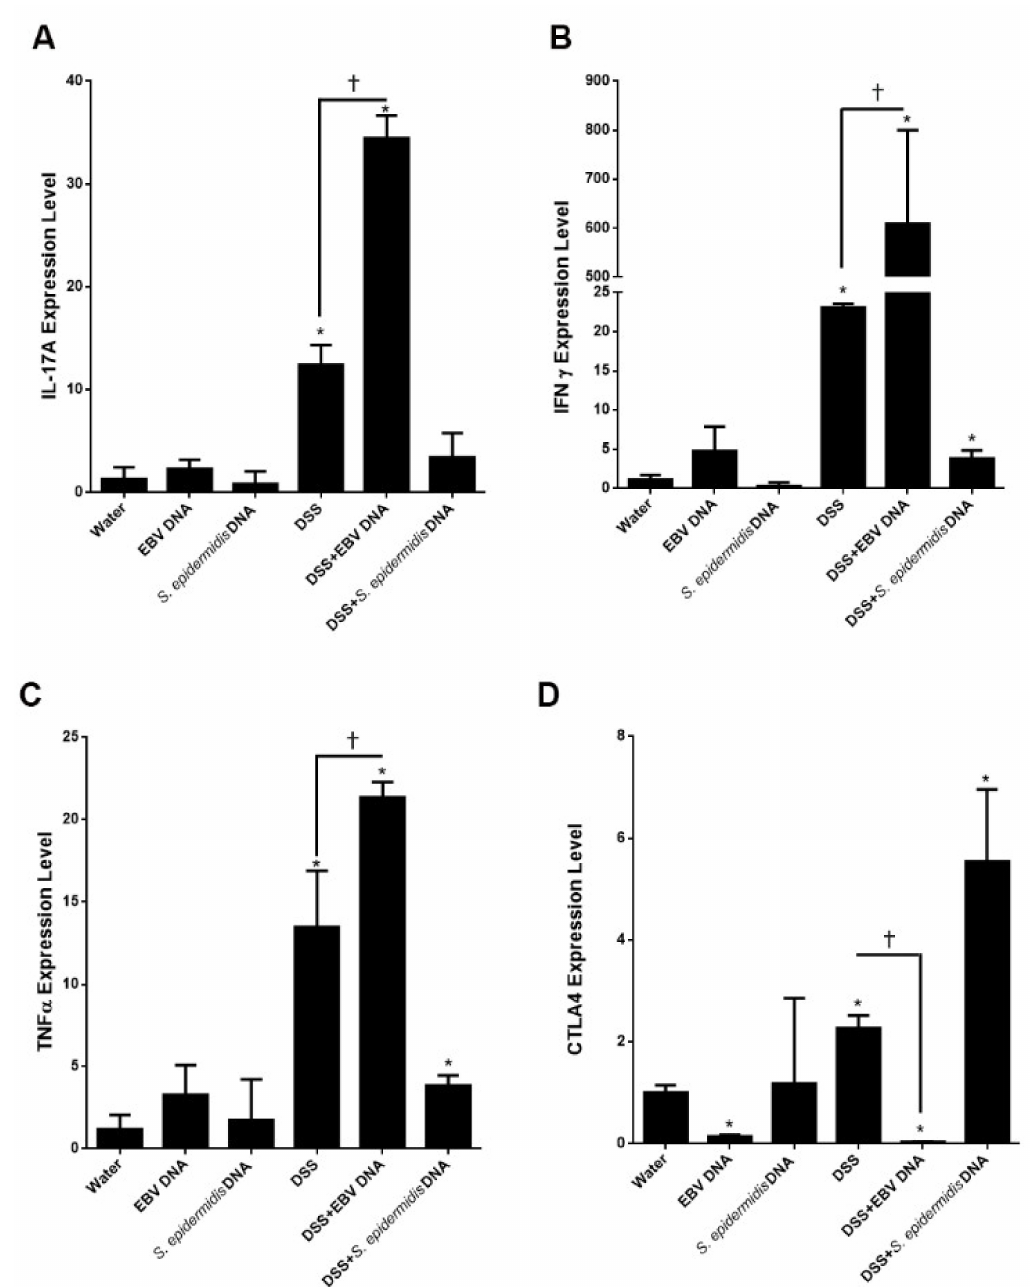
Figure 6. Expression levels of ( A ) IL-17A, ( B ) IFN γ , ( C ) TNF α and ( D ) CTLA4 in control and experimental mouse groups used to assess the effect of Epstein–Barr virus (EBV) DNA on colitis severity in C57BL/6J mice. C57BL/6J mice ( n = 9–14 per group) received either 1.5% dextran sodium sulfate (DSS)-containing or regular drinking water for 7 days. Three DSS-treated groups were then rectally administered sterile water, Epstein–Barr virus DNA in sterile water or S. epidermidis DNA in sterile water on day 3. The other normal drinking water-fed groups were included as controls and also received sterile water, EBV DNA or S. epidermidis DNA by rectal gavage on day 3. On day 7 of the experimental protocol, mice were sacrificed, colons were collected and expression levels were determined in colon sections. Average expression levels per group and standard deviations are indicated. * p < 0.05, compared to the water-treated group; † p < 0.05, compared to the